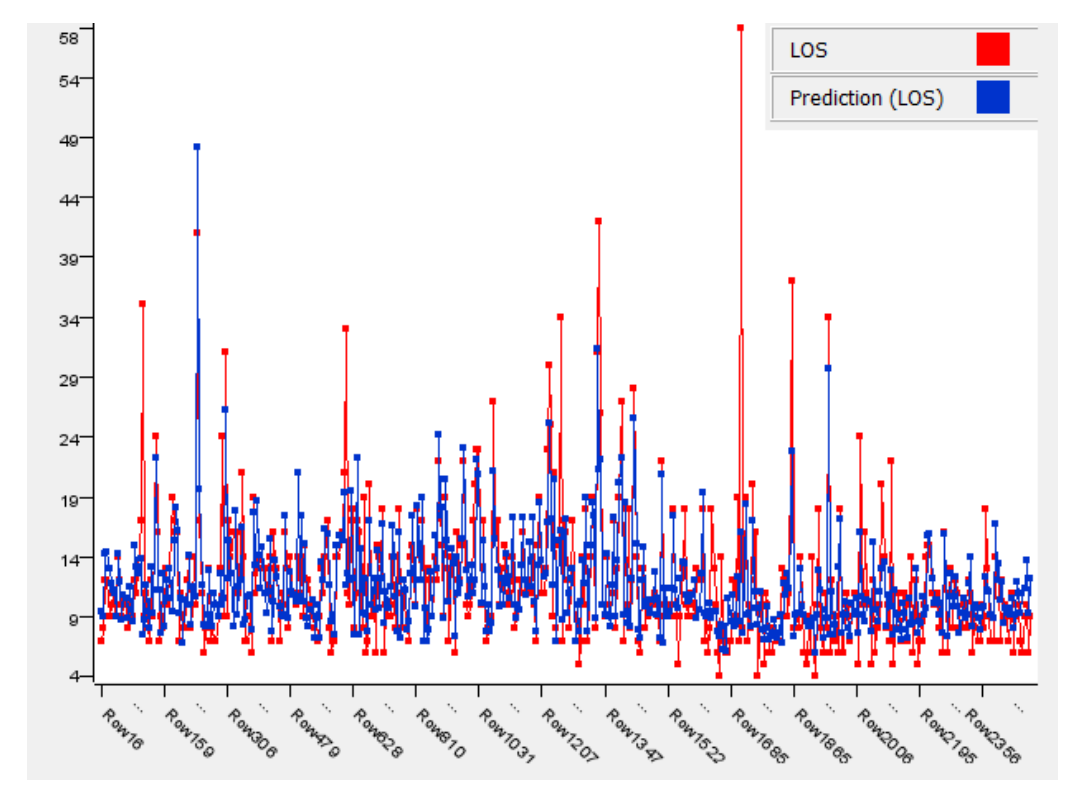
Figure 4. Linear Regression.